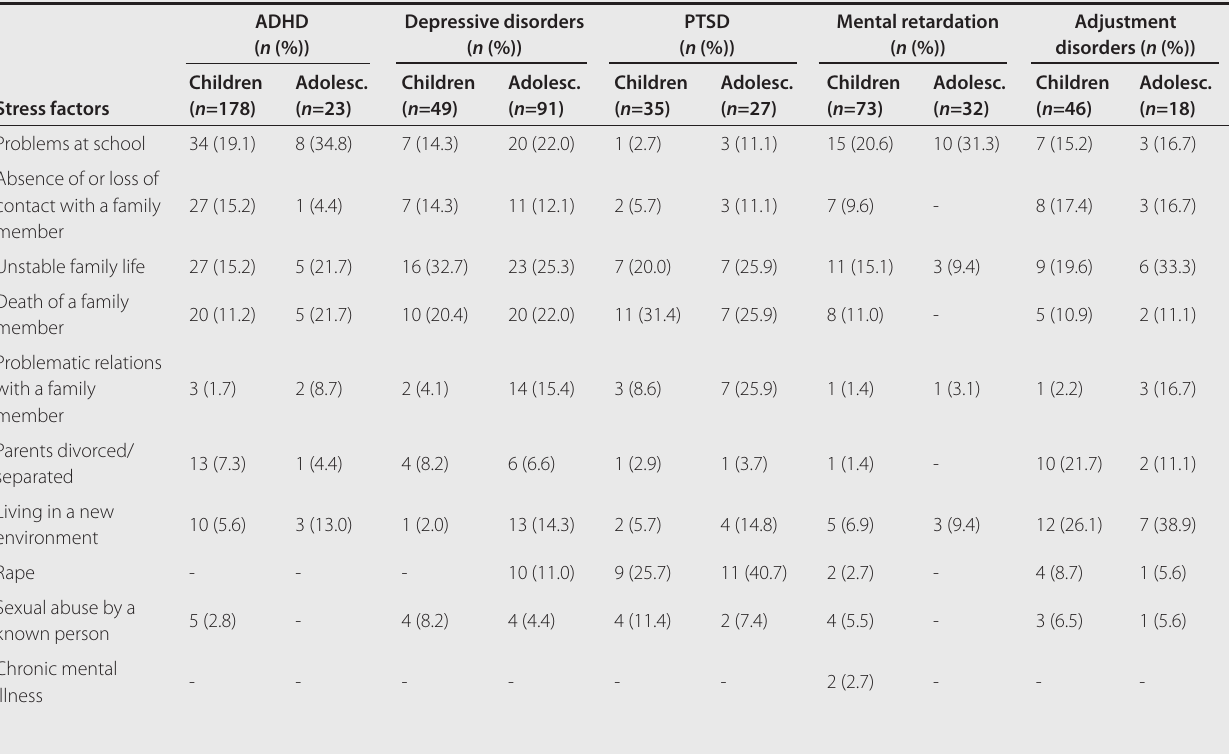
Table 6. The most common stress factors associated with clinical diagnoses in children and adolescents seen at the Child and Adolescent Unit of the FSPC between January 2006 and December 2007